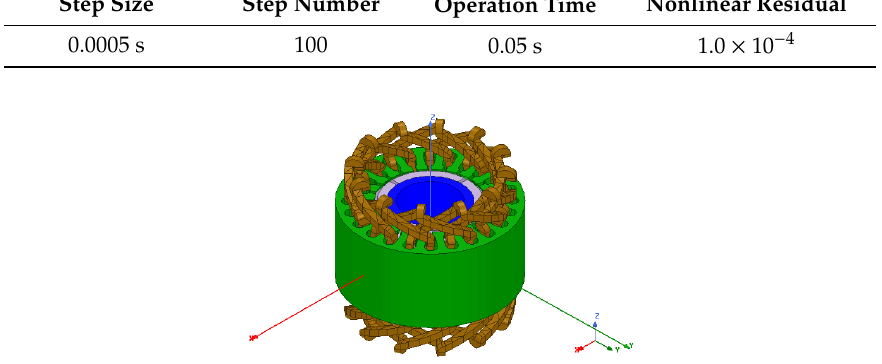
Figure 6. Magnetic dense cloud plot of the rotor. Figure 7. Three-dimensional distribution plot of B r obtained through the finite element analysis. Figure 8. Air-gap flux density comparison diagram for θ = 90°. 3.3. Torque Analysis 3.3.1. Rotation Torque The torque calculation considers the flux linkage before and after virtual displacement as constant, while the system is considered free of loss. Thus, the formula for estimating the total energy stored in the solution domain is given as: